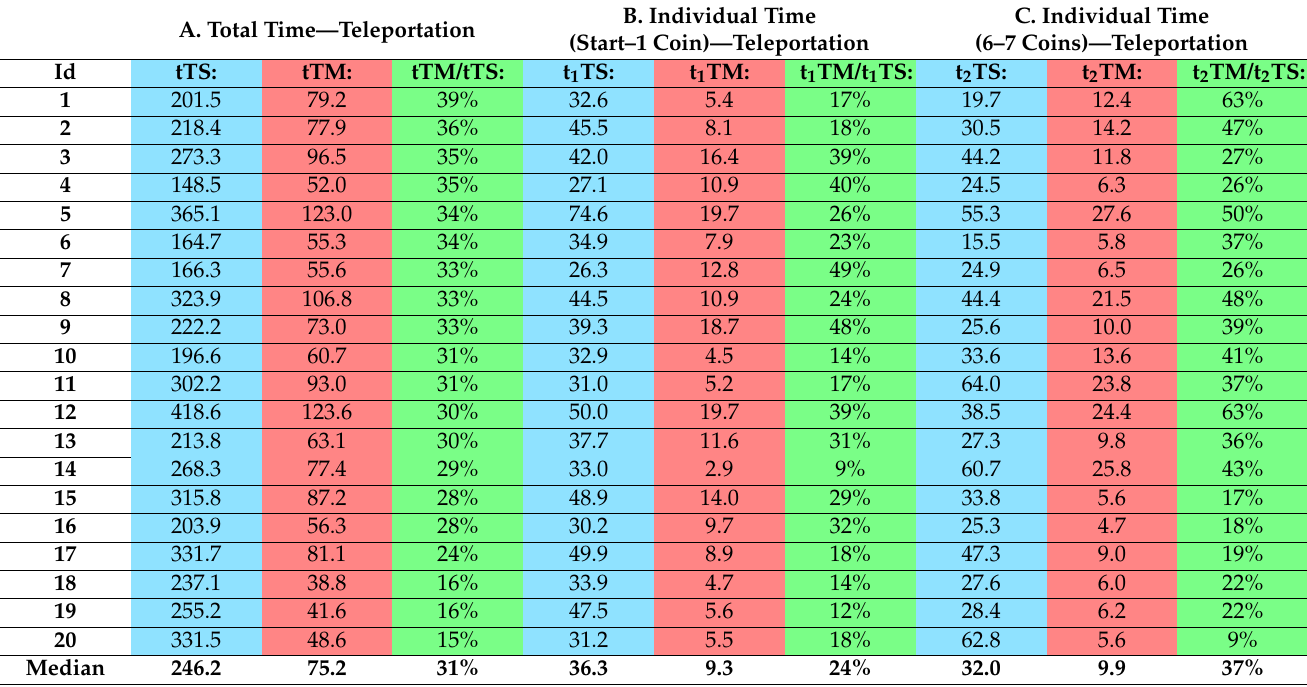
Table 2. Time data for teleportation (20 gamers). The total game time for teleporting gamers—tTS (time-Teleportation-Space), the mini-map examination time for teleporting gamers—tTM